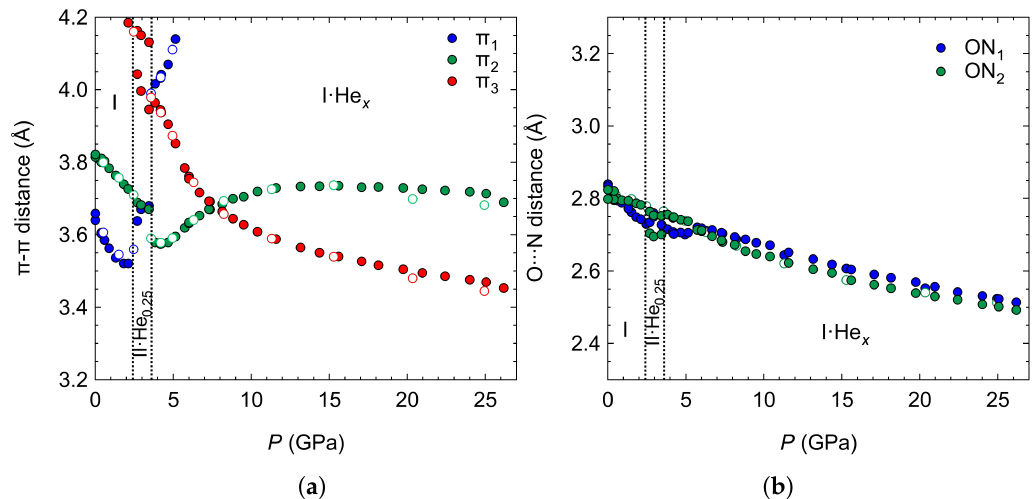
Figure 5. ( a ) The π − π distances on compression between the two initially parallel 4HCB molecules (which are symmetry related in the Pbcn phase), where the blue and green markers indicate the 3.6 and 3.8Å π − π interaction, respectively at ambient and the red markers are for the new interactions that form within the square-shaped columns as indicated in Figure 3. ( b ) O · · · N hydrogen bonding distances on compression, where the colour of the markers indicate the same direction of H-bonding as the π − π